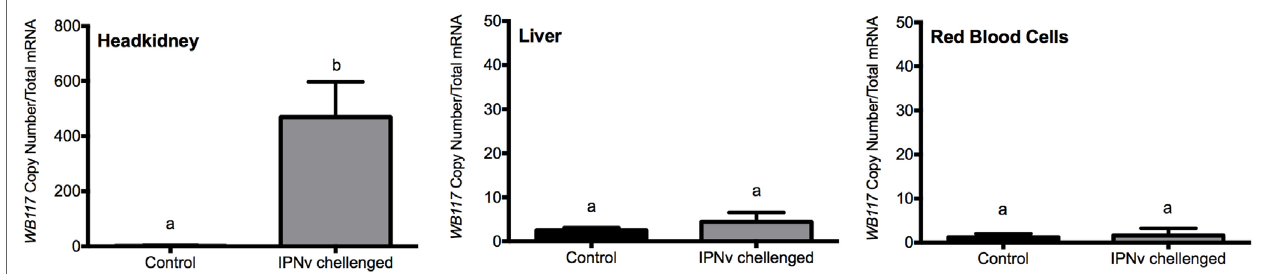
FigUre 1 | Viral load expressed in terms of VP2 segment abundance. Measured by qPCR from headkidney, liver, and red blood cells. The experimental groups are: virus free (control, black bar), and infectious pancreaticc necrosis virus challenged (gray bar). Different letters denote significant differences between groups. Values are represented as the mean VP2 copy number ± SD. Different letters denote significant differences between experimental groups (two-way ANOVA; p < 0.05; p < 0.0001).